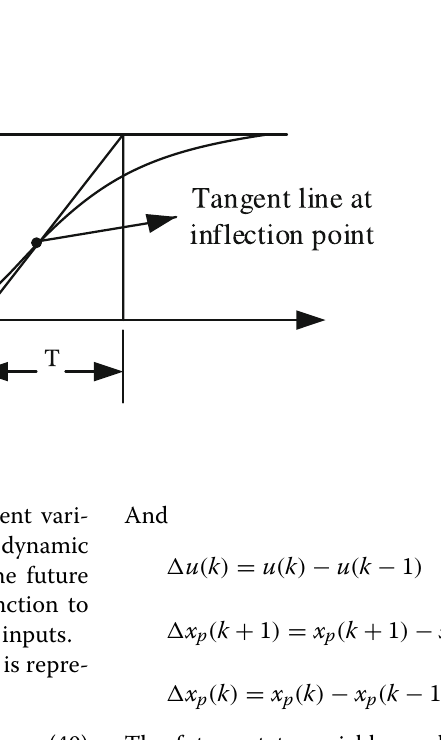
in the dependent variables caused by independent vari- ables. MPC uses the current plant measurement, dynamic state, the process variable target to calculate the future events. This controller uses predefined cost function to calculate the optimal values of the future control